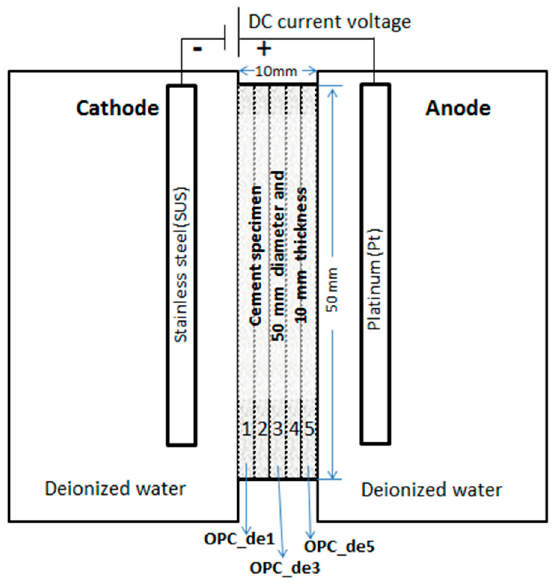
Figure 1. Schematic diagram of the accelerated leaching test of cement paste and regions of interest where 5 specimens were obtained (OPC_de1, OPC_de2, OPC_de3, OPC_de4, and OPC_de5).